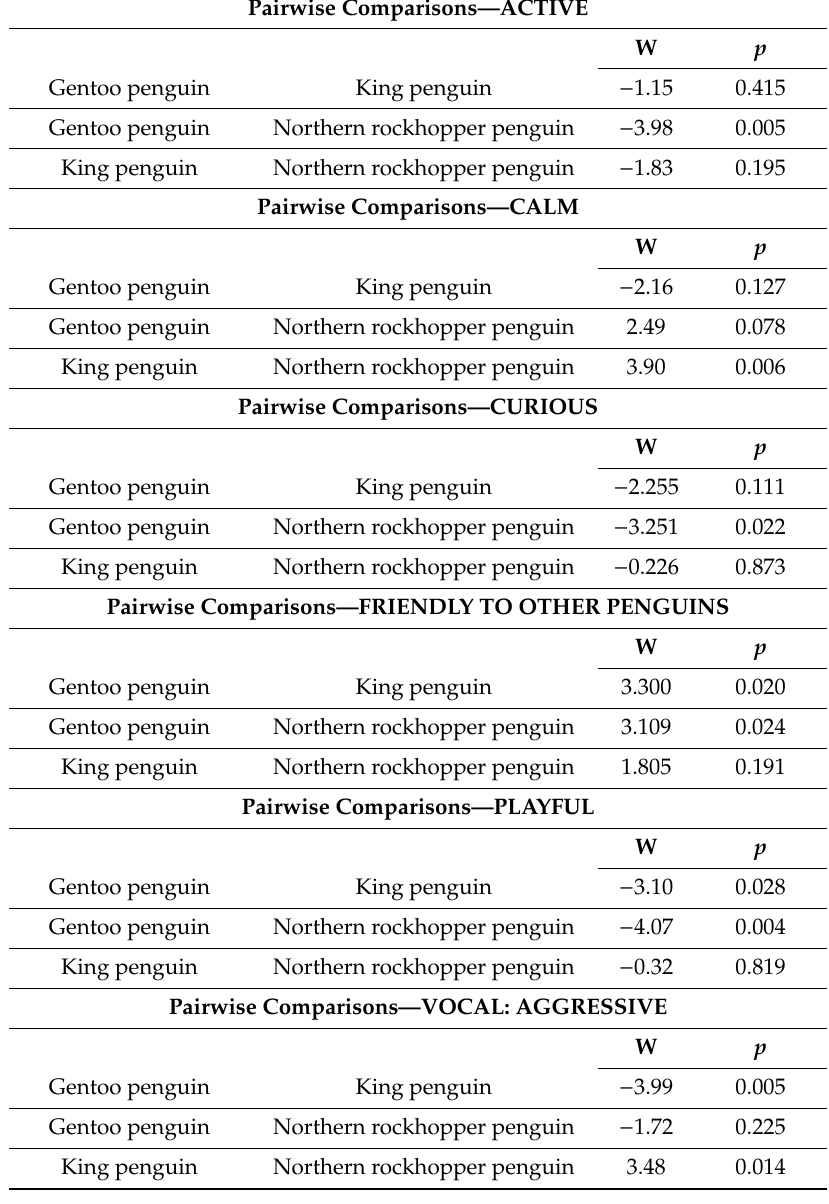
Table 3. Dwass-Steel-Critchlow-Fligner (DSCF), test for multiple comparisons analysis of the di ff erences between the median values of the personality traits, rated by the keepers, in the three species of penguin. W = Wilcoxon rank sum test statistic; p < 0.05 values are considered as statistically di ff erent. Only statistically di ff erent results are